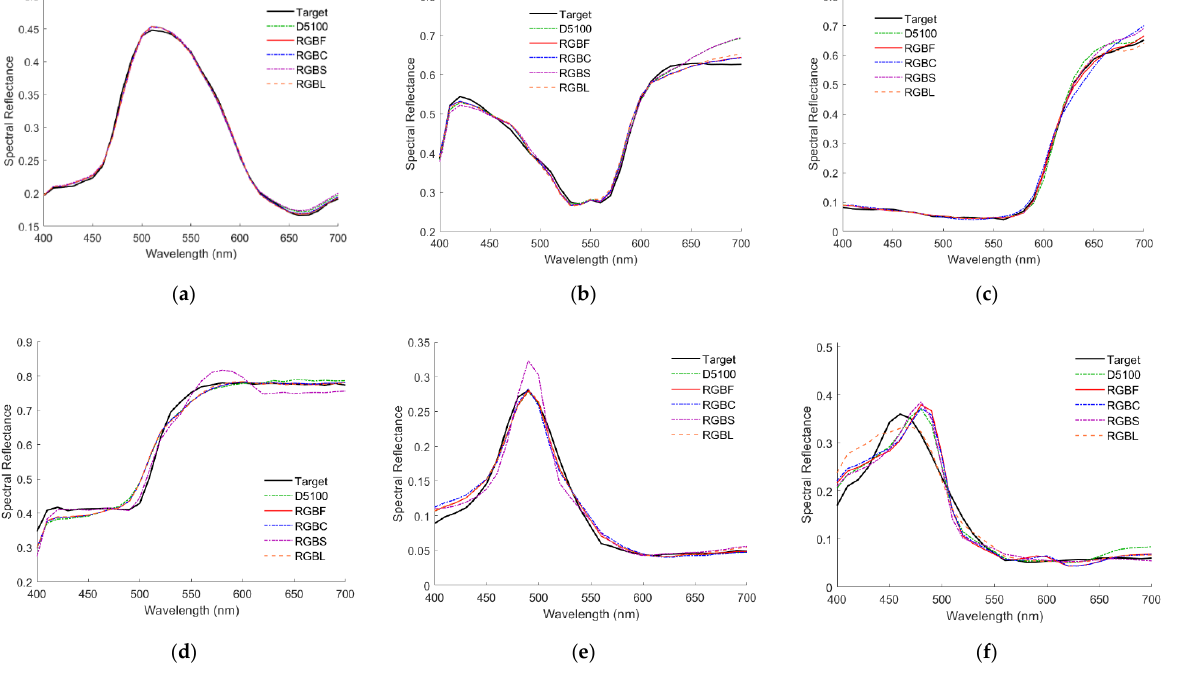
Figure 9. The target spectra S Ref and recovered reflectance spectra S RefRec of the test samples with the ( a ) 2.5G 7/6, ( b ) 10P 7/8, ( c ) 2.5R 4/12, ( d ) 2.5Y 9/4, ( e ) 10BG 4/8 and ( f ) 5PB 4/12 color chips. The cameras are indicated. Spectra are reconstructed using the LUT method.